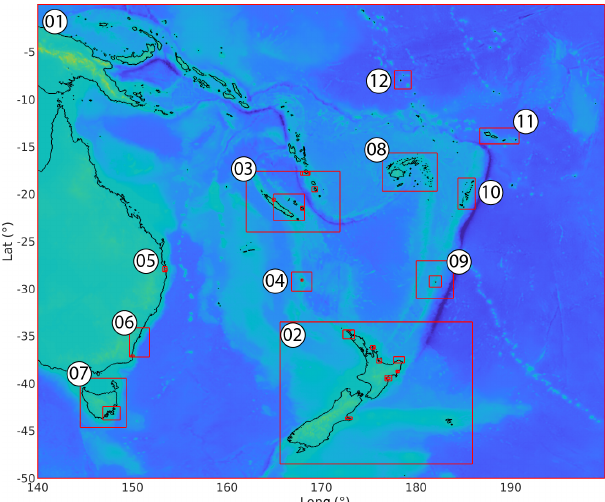
Figure 8. Extent of the grids used for modelling within the frame- work of the study. Grid 01 (first level) covers the south-west Pacific region, from 140 to 200 ◦ E and from 50 to 0 ◦ S, with spatial res- olution of 2arcmin. Numbers are associated with the grids of the second level with spatial resolution of 30 or 24arcsec. Higher res- olution grids corresponding to additional levels are only indicated with red